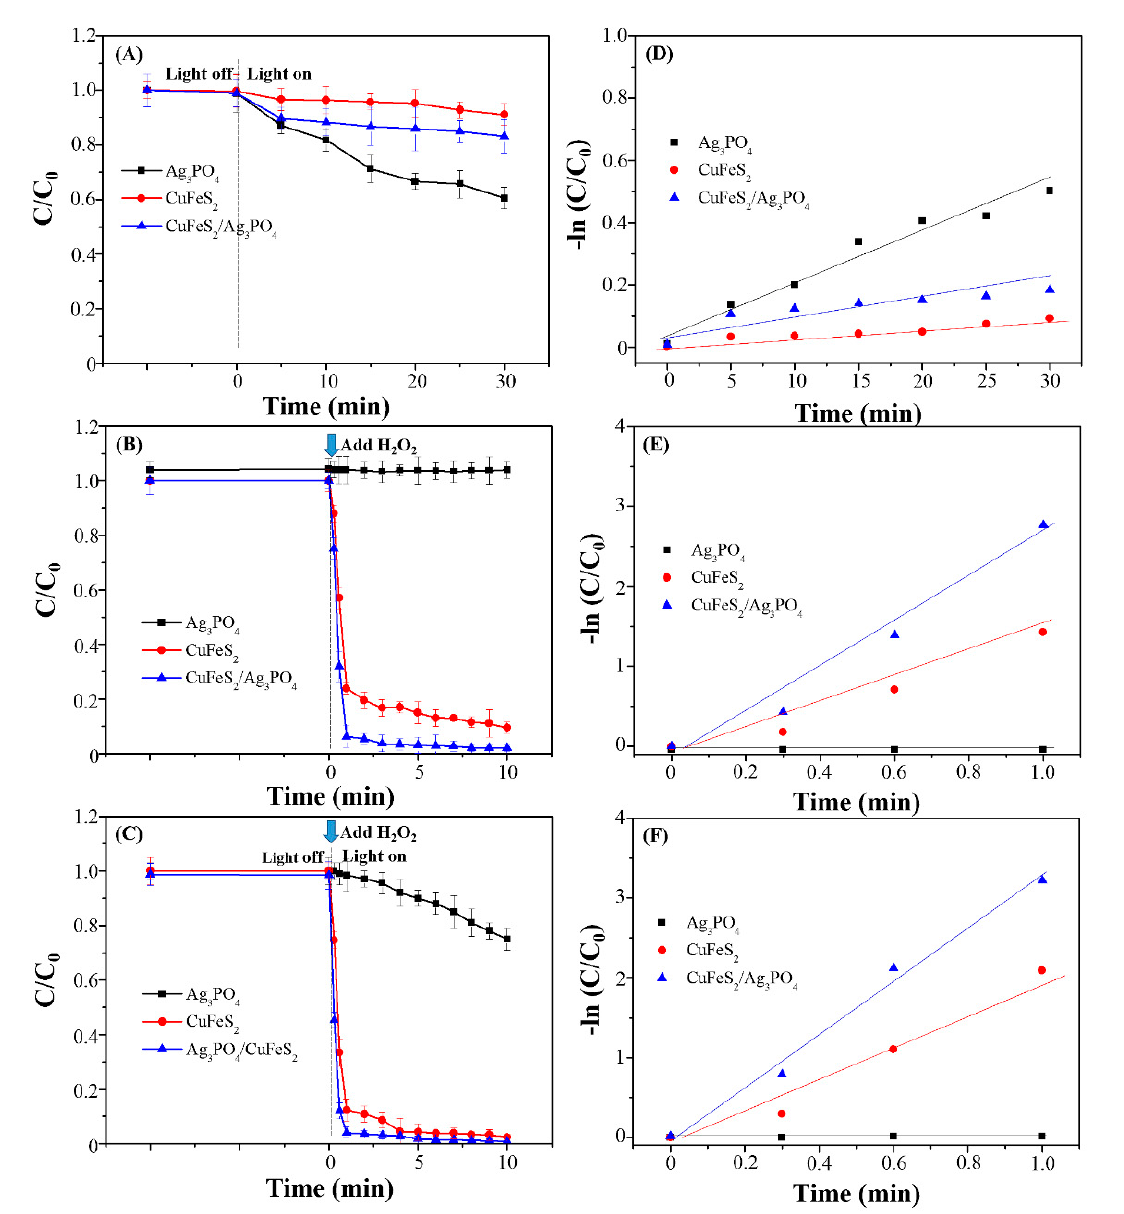
Figure 9. ( A ) Photocatalytic reaction; ( B ) fenton reaction; and ( C ) photo-Fenton reaction for RhB degradation by different samples: Ag 3 PO 4 (black), CuFeS 2 (red), and CuFeS 2 /Ag 3 PO 4 composites (blue). The pseudo-first order linear transform of RhB degradation under ( D ) photocatalytic reaction, ( E ), Fenton reaction and ( F ) photo-Fenton reaction by different samples: Ag 3 PO 4 (black), CuFeS 2 (red), and CuFeS 2 /Ag 3 PO 4 composites (blue).